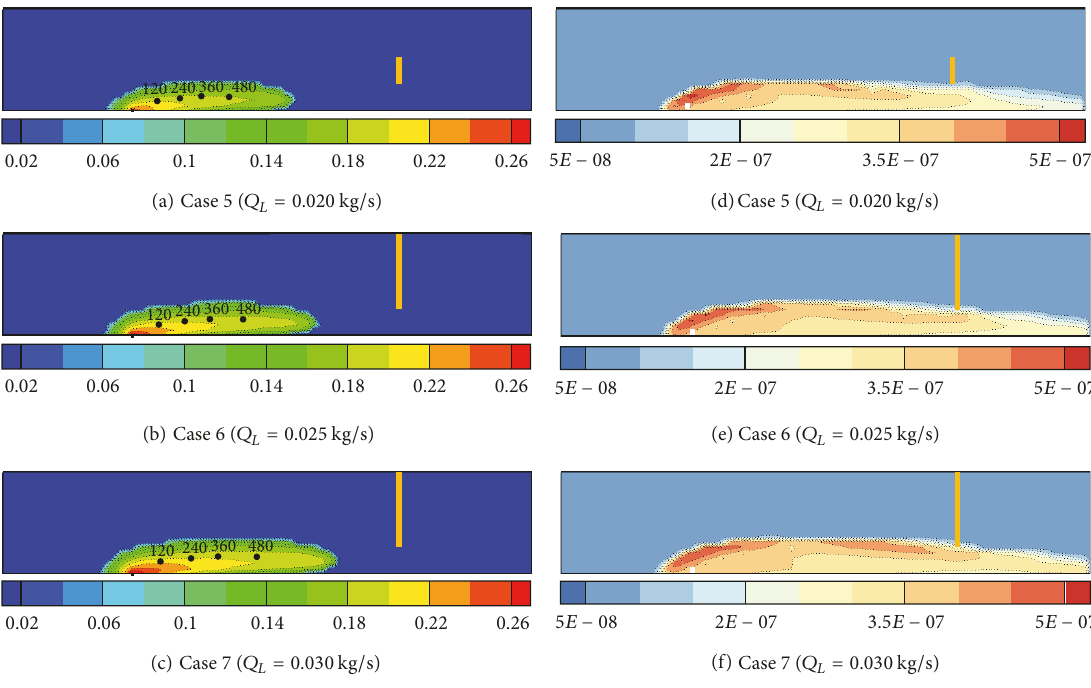
Figure 11: Saturation of leaked CO 2 at different leakage rates after 1 year (365 days). (a) Case 5, (b) Case 6, and (c) Case 7. Black circles with labels indicate the locations of mass center for CO 2 plume. Distribution of ∑ As concentration induced by leaked CO 2 at different leakage intensities ( 𝑄 𝐿 ) after 20 years. (d) Case 5, (e) Case 6, and (f) Case 7.